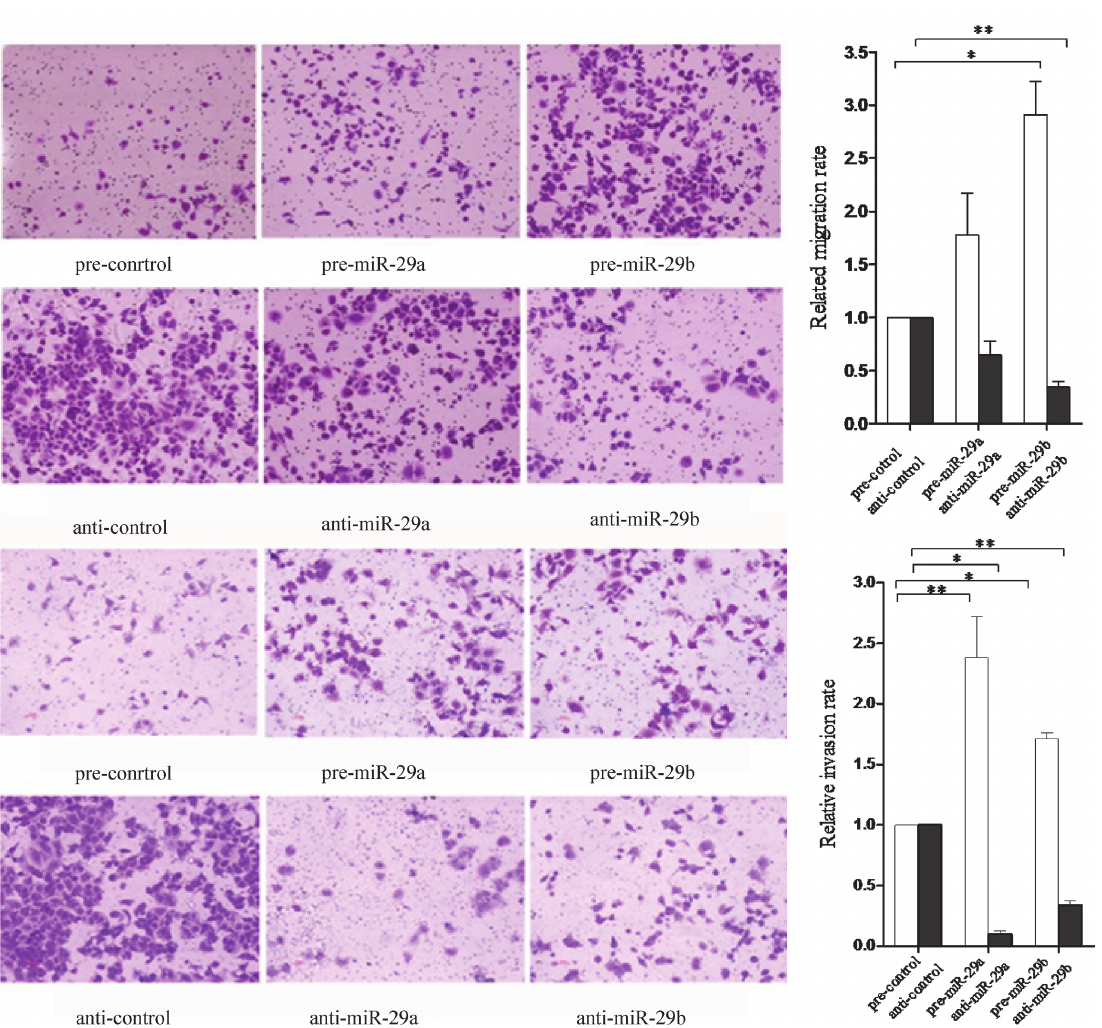
Fig 4. Effects of miR-29a/b expression on NPC cell migration and invasion. (A, B) Transwell migration and invasion assays showing the effect of miR- 29a/b overexpression or knockdown on the migrated and invasive activity of S18 cells transfected with pEGFP-miR-29 or anti-miR-29. The migrated and invasive NPC cells that grew on the lower surface were stained and counted manually using a microscope (original magnification 50×) at 24 h after reseeding. Representative images are shown in the left panel. The mean number of cells per visual field was determined in four randomly selected visual fields per chamber and the experiments were performed in triplicate (right panel). * p <